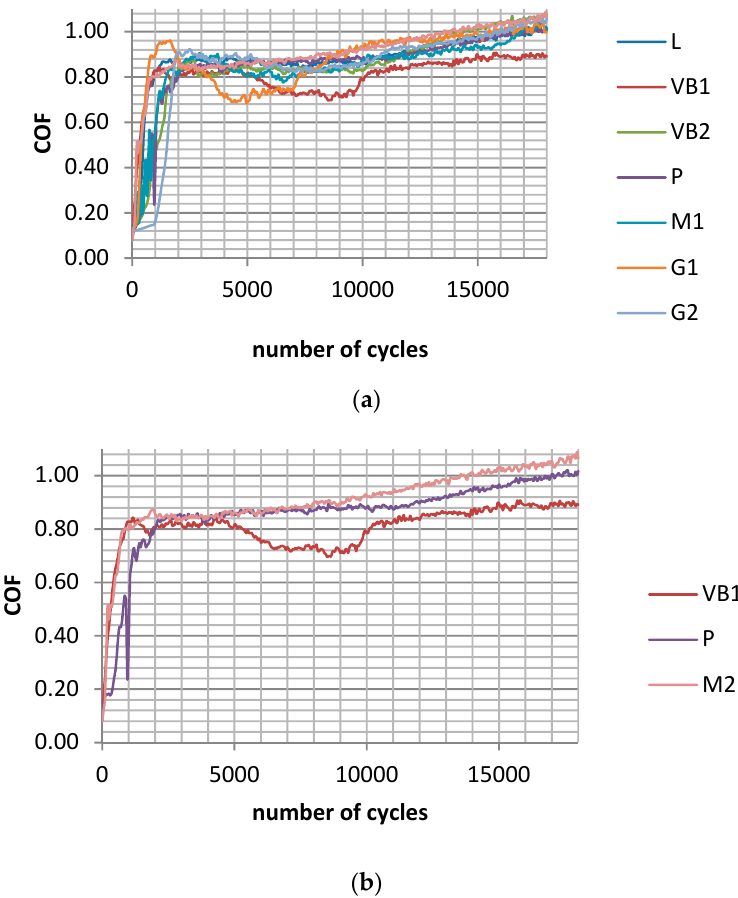
Figure 7. Maximum coefficient of friction during test F for sliding pairs with all ( a ) and selected discs after vapour blasting VB1, after lapping L and after milling M2 ( b ) for the following operating parameters: s = 0.1 mm, P = 45 N, f = 50 Hz.